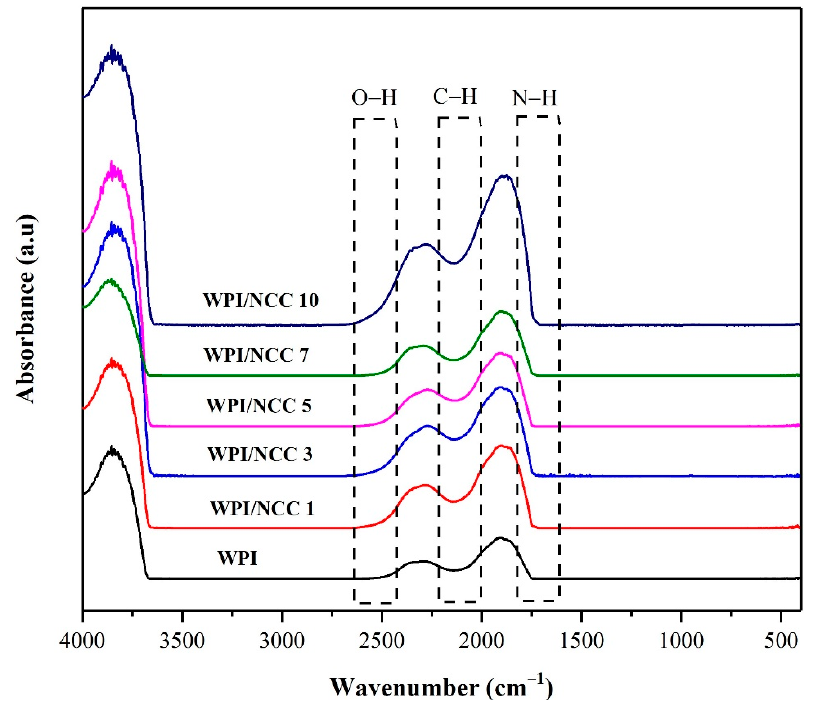
Figure 4. FTIR Spectra of whey protein film combined with nanocrystalline cellulose.